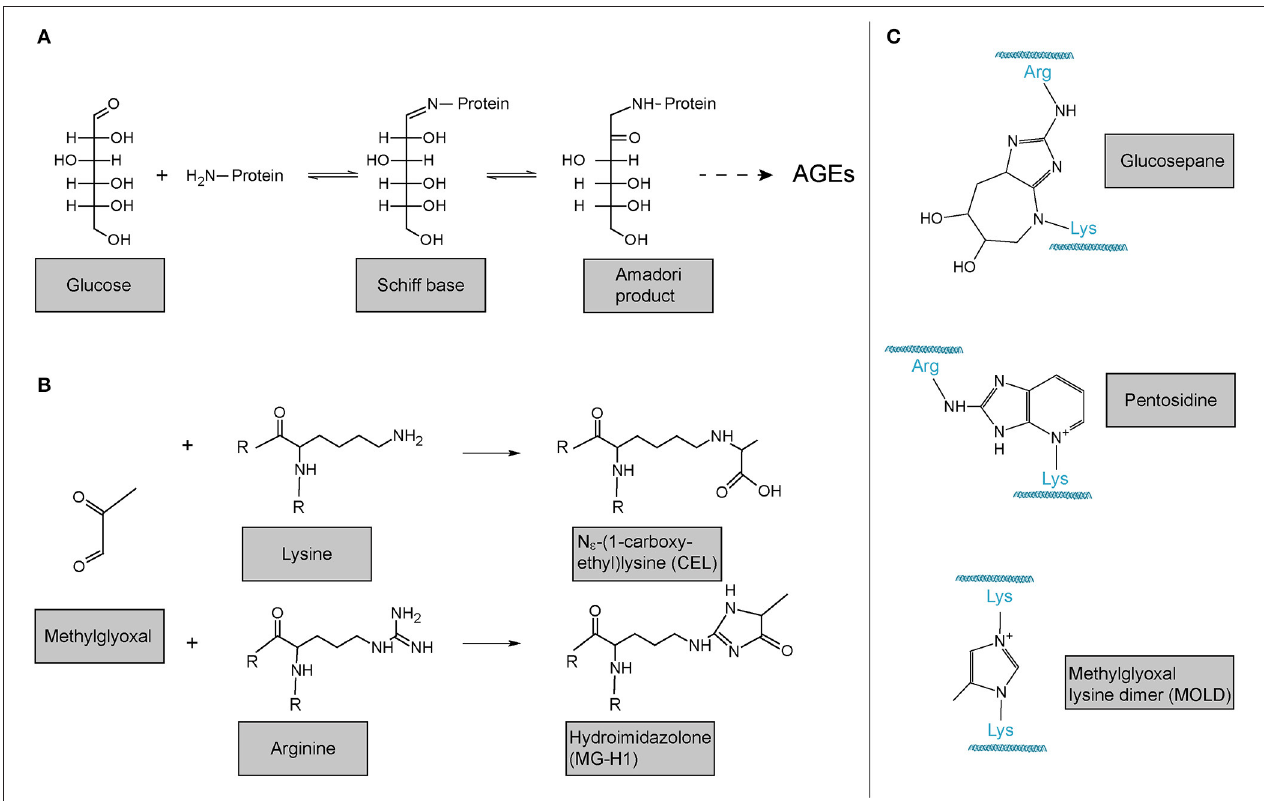
FIGURE 6 | Advanced glycation endproducts (AGE)-mediated collagen modification and crosslinking. (A) In the classical Maillard reaction, a reducing sugar (here: glucose) reacts with an amino group in a protein, e.g., the protein’s amino terminus or amino groups of the side chains arginine or lysine. The resulting Schiff base rearranges to a ketoamine, the so-called Amadori product. Subsequent reactions of this initial product result in the irreversible formation of different protein adducts and crosslinks, collectively termed advanced glycation endproducts (AGEs). (B) Reactions of the dicarbonyl methylglyoxal with protein lysines or arginines results in the formation of protein adducts as e.g., N ε -(1-carboxyethyl)lysine (CEL) or the hydroimidazolone MG-H1. (C) Structures of some of the most common AGE-mediated crosslinks. Structures were generated using ACD/Chemsketch